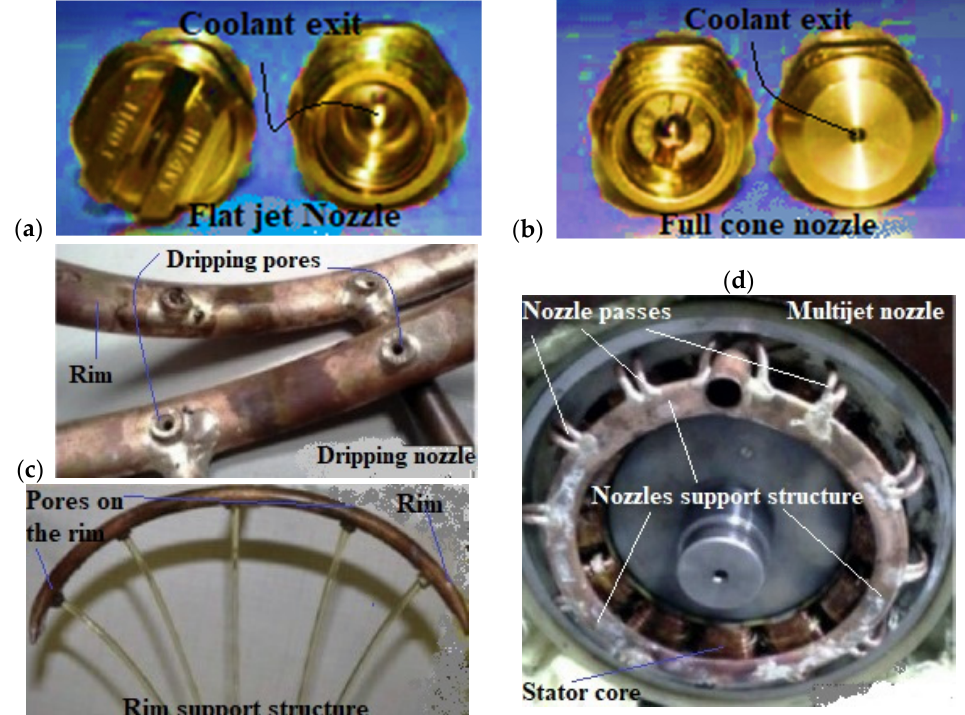
Figure 10. ( a ) Spiral water jacket; ( b ) Bifurcated U-shaped water jacket; ( c ) Axial water jacket; ( d ) Dial water jacket [42,43].